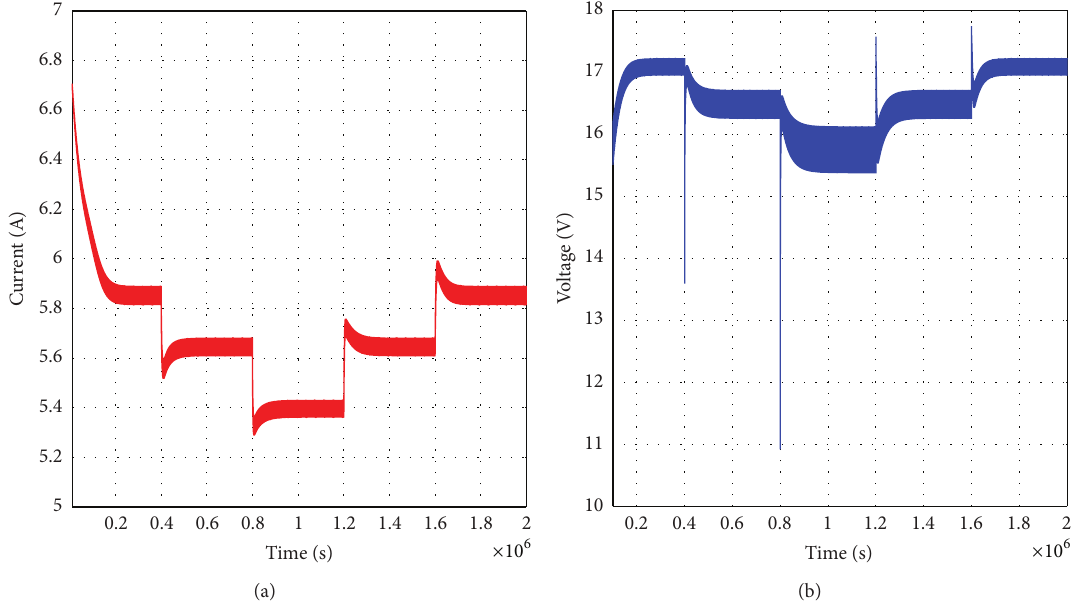
Figure 7: (a) shows the current at maximum power under varying irradiance condition and (b) shows voltage at maximum power under varying irradiance